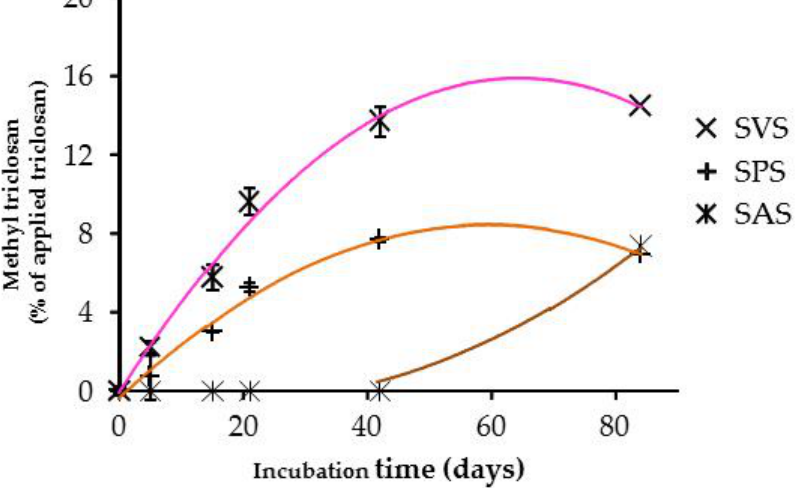
Figure 2. Percentages of the metabolite methyl-triclosan determined at different incubation time in SAS, SVS and SPS biomixtures from different biopurification systems. Error bars indicate the standard deviation (n = 3).